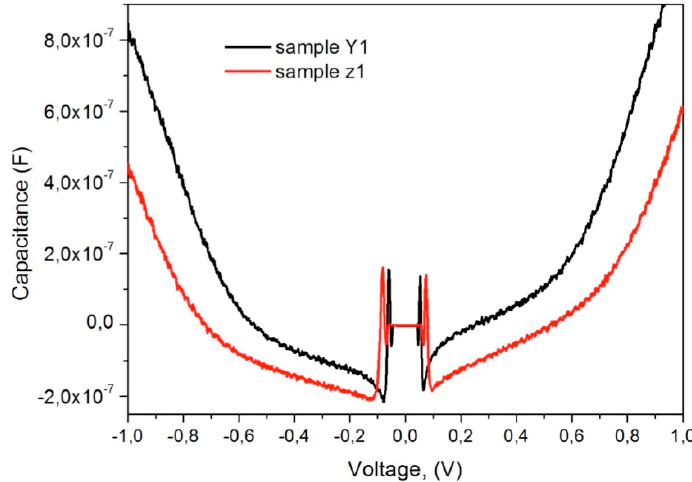
Figure 14. Frequency dependence of dielectric loss ε ” for PVA/ZnO composites.